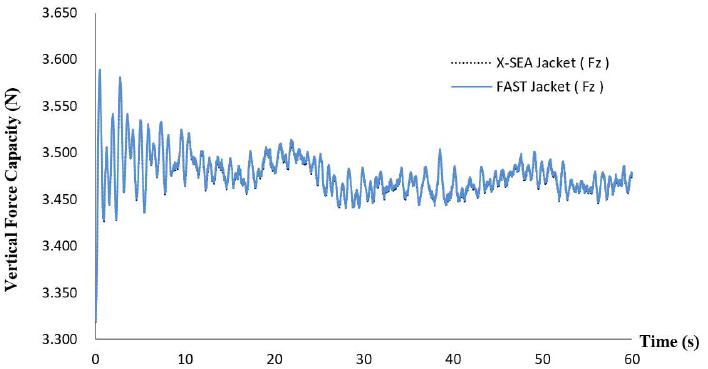
Figure 7. Comparison of the dynamic vertical reaction force capacity on the jacket support structure in the z-direction resulted from X-SEA and FAST v8 programs.